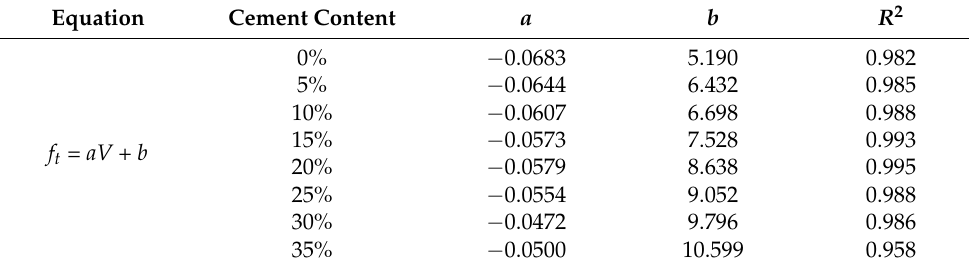
Figure 4. The relationship between compressive strength and foam volume. Table 5. The fitting results of the flexural strength ( f t ) and foam volume ( V ).